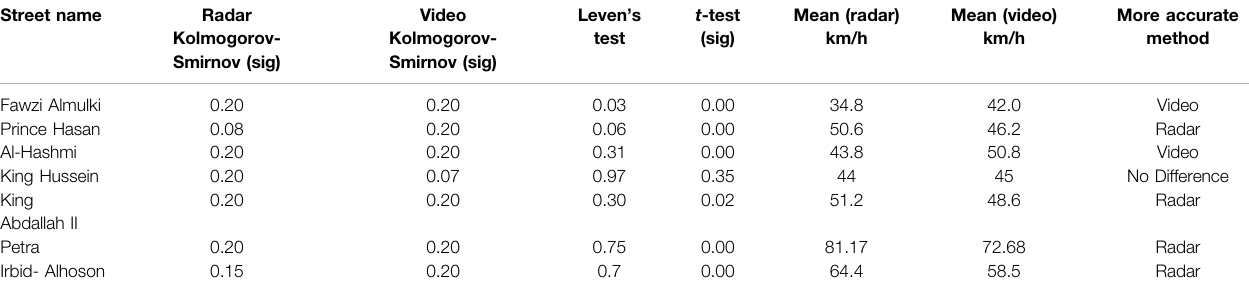
TABLE 5 | Kolmogorov-Smirnov test and independent samples t -Test results for each street.